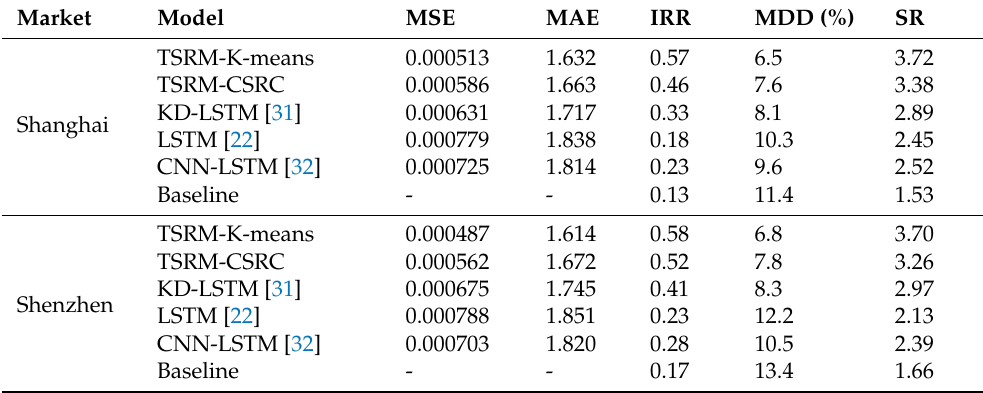
Table 3. Comparison of models’ backtesting experimental.